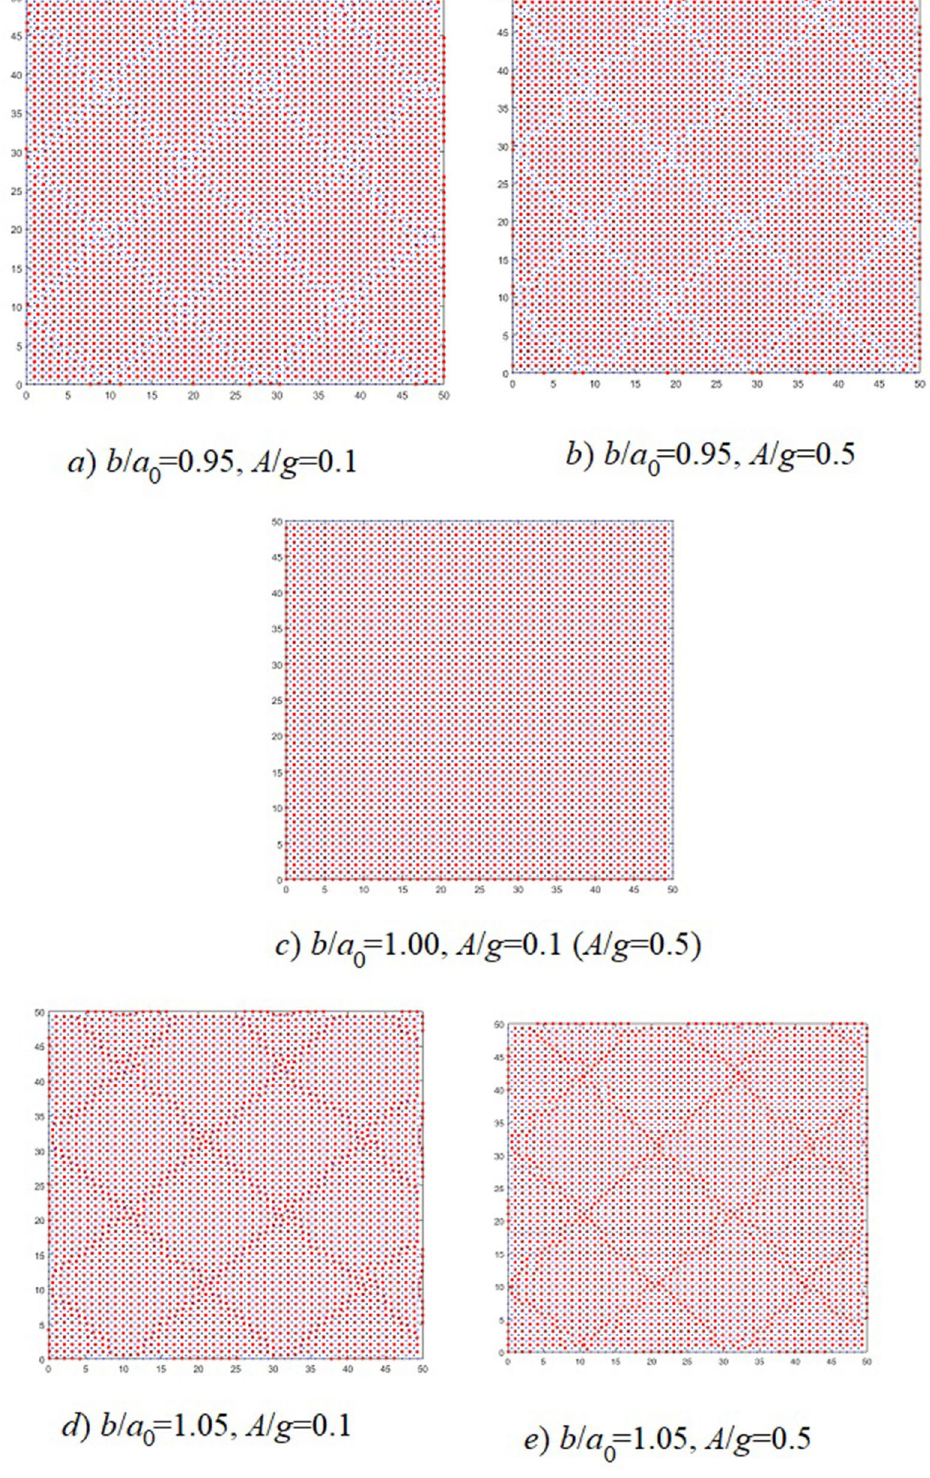
Figure 1. Placement of film atoms at different values substrate period b and potential amplitude A for a system with linear size L = 50